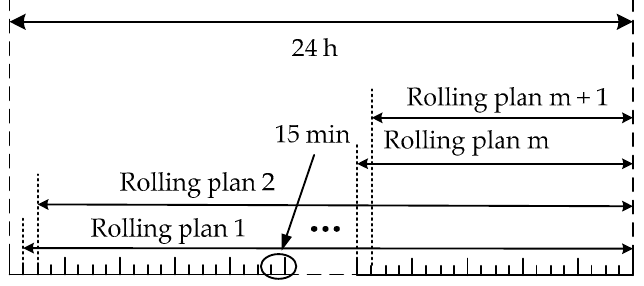
Figure 3. The adapted intra-day rolling scheduling strategy.